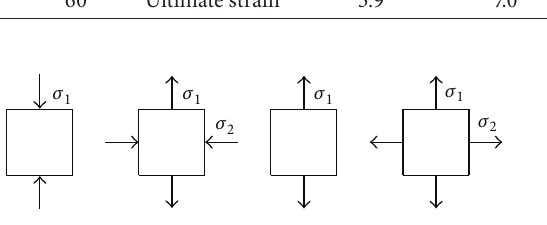
Figure 1: Four basic load cases